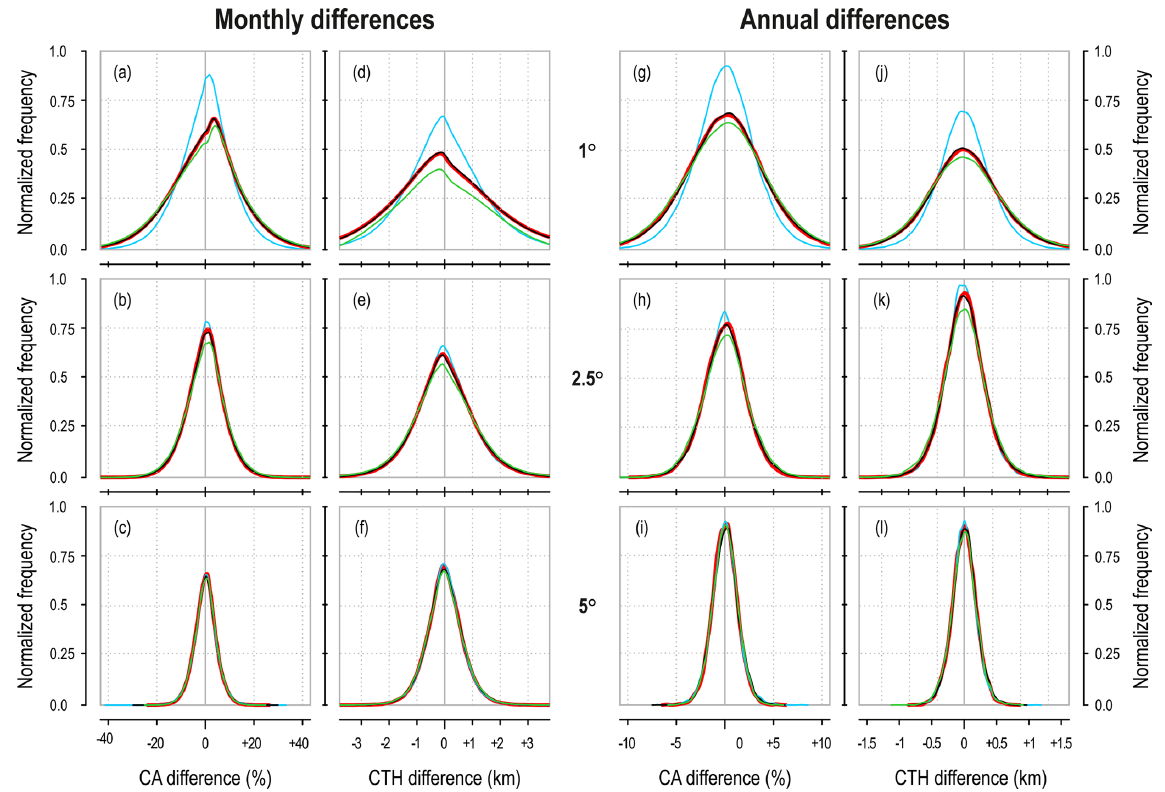
Figure 1. Differences between n day and 1d revisit cloud amounts, and cloud top heights at monthly (a–f) , and annual (g–l) mean timescales, for CALIPSO (red), EarthCARE (black), Aeolus (blue), and ICESat-2 (green). In all cases, n day values are subtracted from 1d